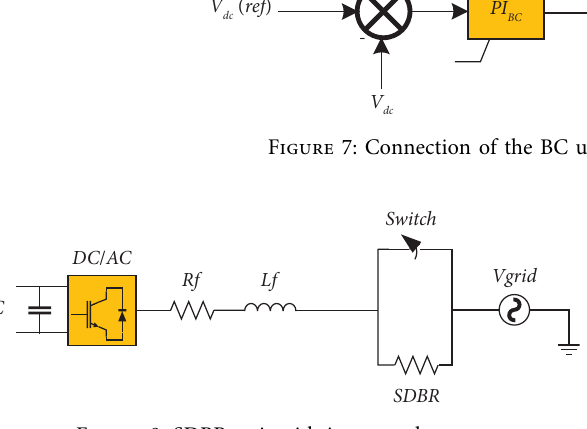
Figure 8: SDBR unit with its control